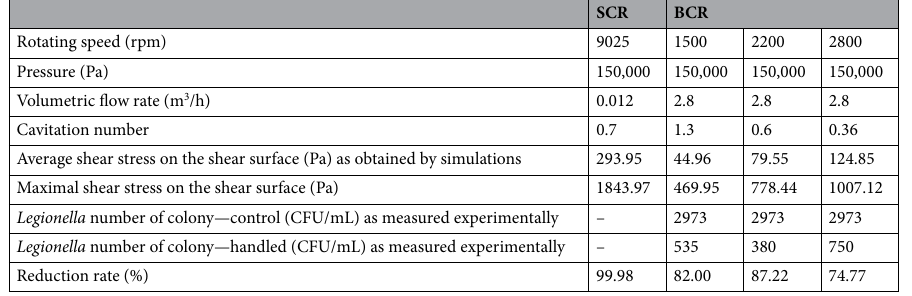
Table 3. Summary of results.